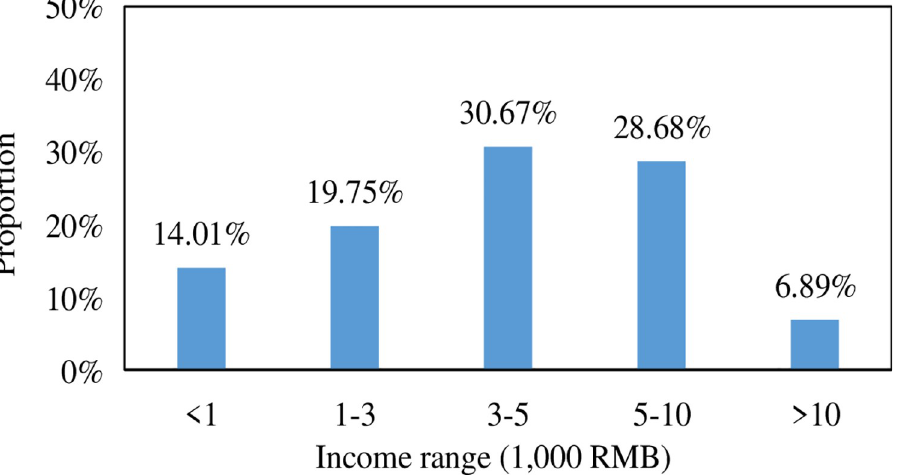
Fig 5. Beijing metropolitan population disposable income